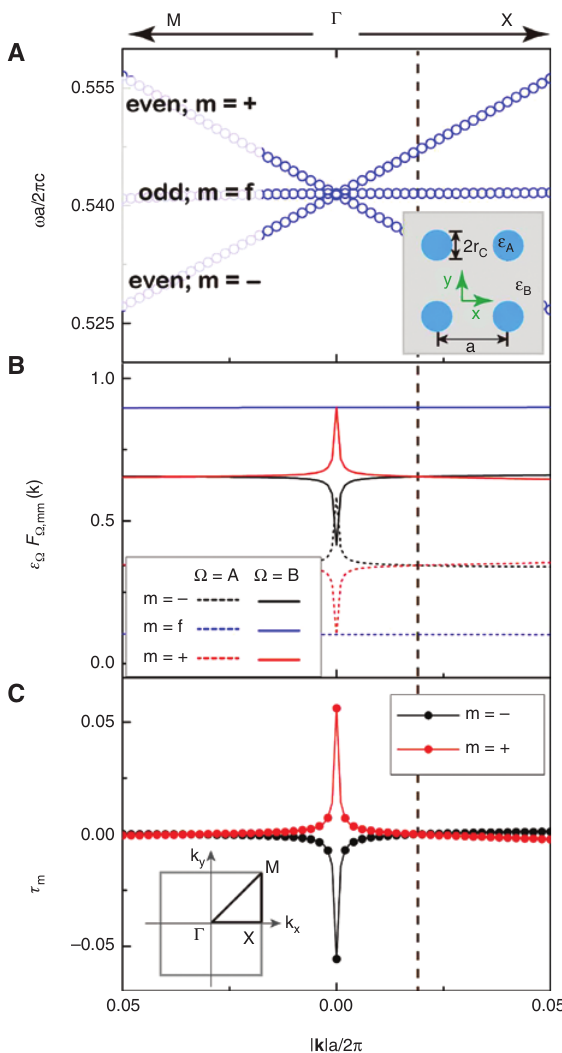
Figure 1: Properties of the Dirac-like